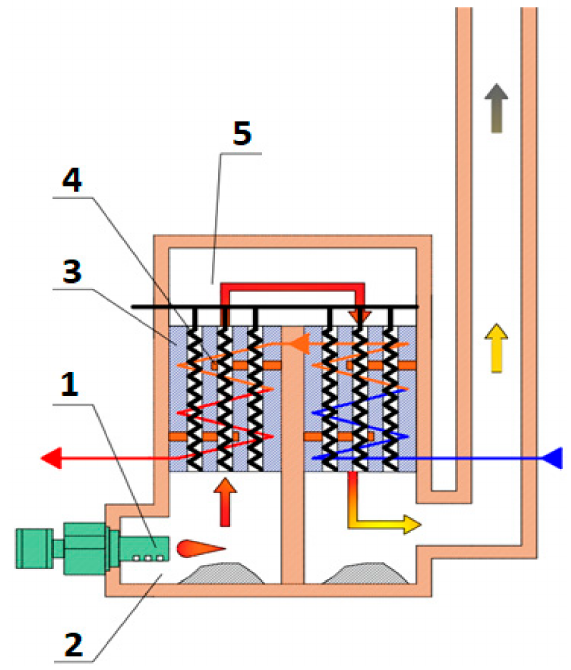
Figure 2. Proposed device used to combustion of wheat-straw